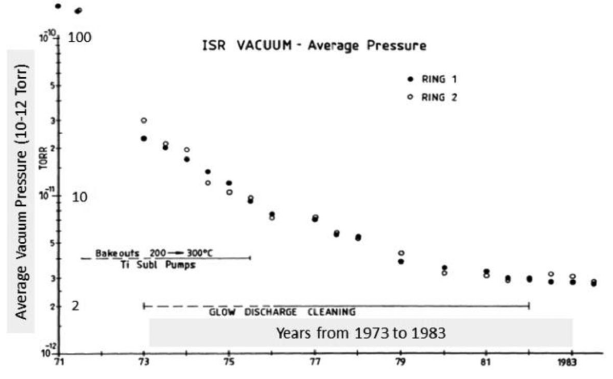
FIG. 20. Time evolution of the ISR vacuum pressure.